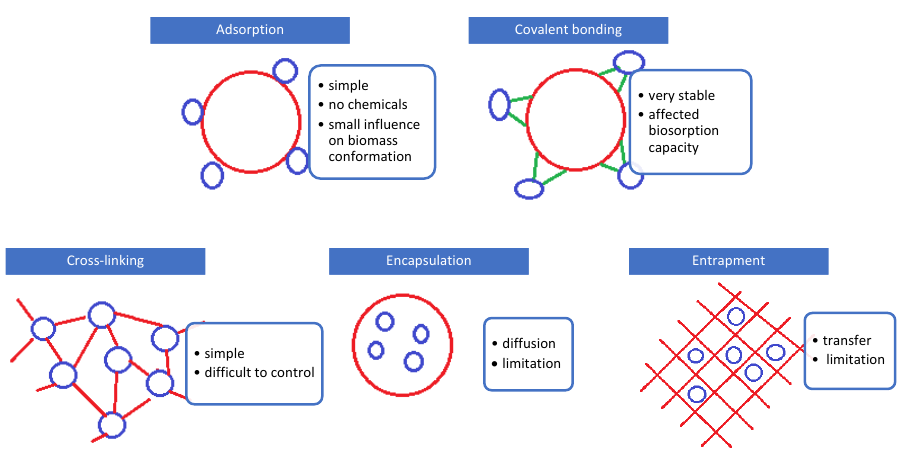
Figure 2. Immobilization techniques for biomass-based biosorbent synthesis.